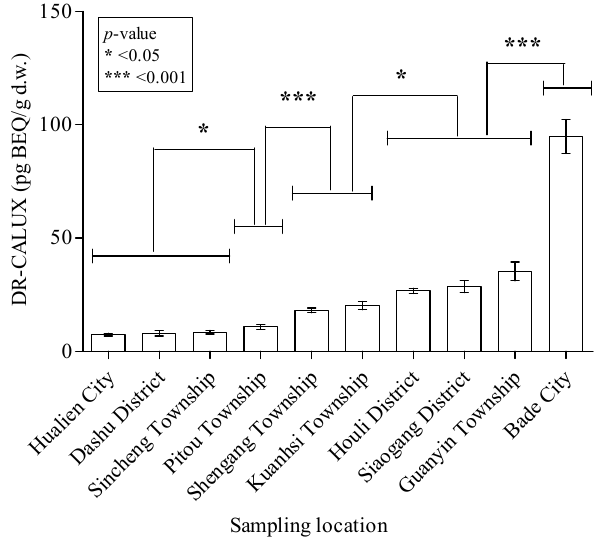
contamination, with significantly higher levels compared to those from land used for other purposes (20.0 ± 12.0 pg-BEQ/g d.w.) ( p < 0.01). Figure 2. Dioxin concentrations in Taiwanese soil from 10 cities, districts, or townships (n = 685). The dioxin levels are markedly higher in soil collected from Bade City than in soil collected from the other surveyed areas ( p < 0.001); significantly higher in Guanyin, Siaogang, and Houli than in the other areas except for Bade City ( p < 0.05 or p < 0.001); significantly higher in Kuanhsi and Shengang than in Pitou, Sincheng, Dashu, and Hualien City ( p < 0.001); slightly higher in Pitou than in Sincheng, Dashu, and Hualien City ( p < 0.05), and lowest in Sincheng, Dashu, and Hualien City among the 10 selected survey areas ( p < 0.05 or p < 0.001).